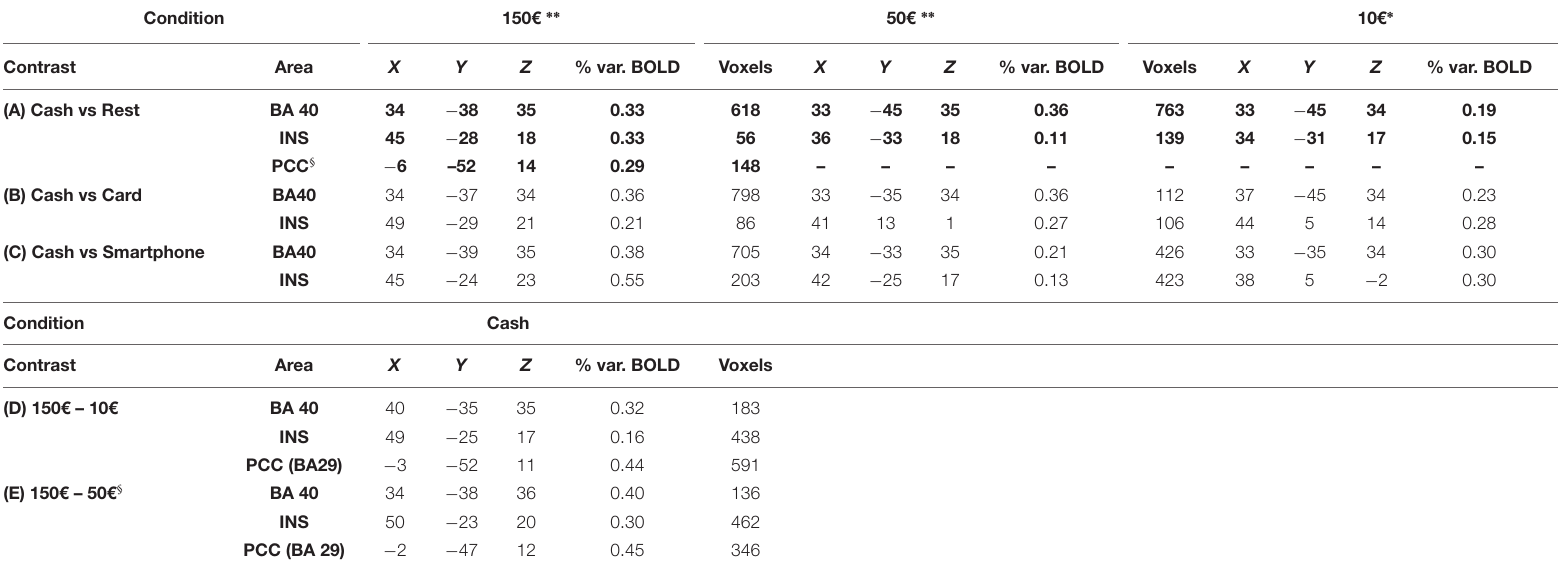
TABLE 1 | Talairach coordinates, percent of signal increase and activated voxels in the cortical activated areas as obtained from multisubjects analysis. Condition